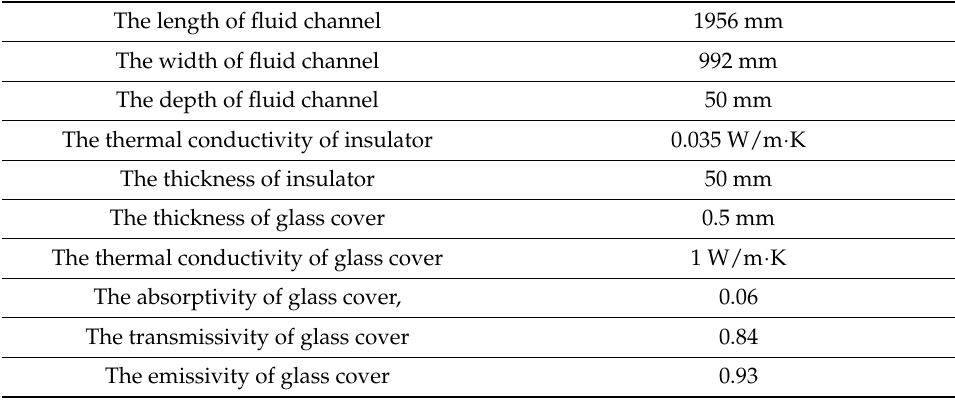
Table 7. Design parameters of fluid channel.